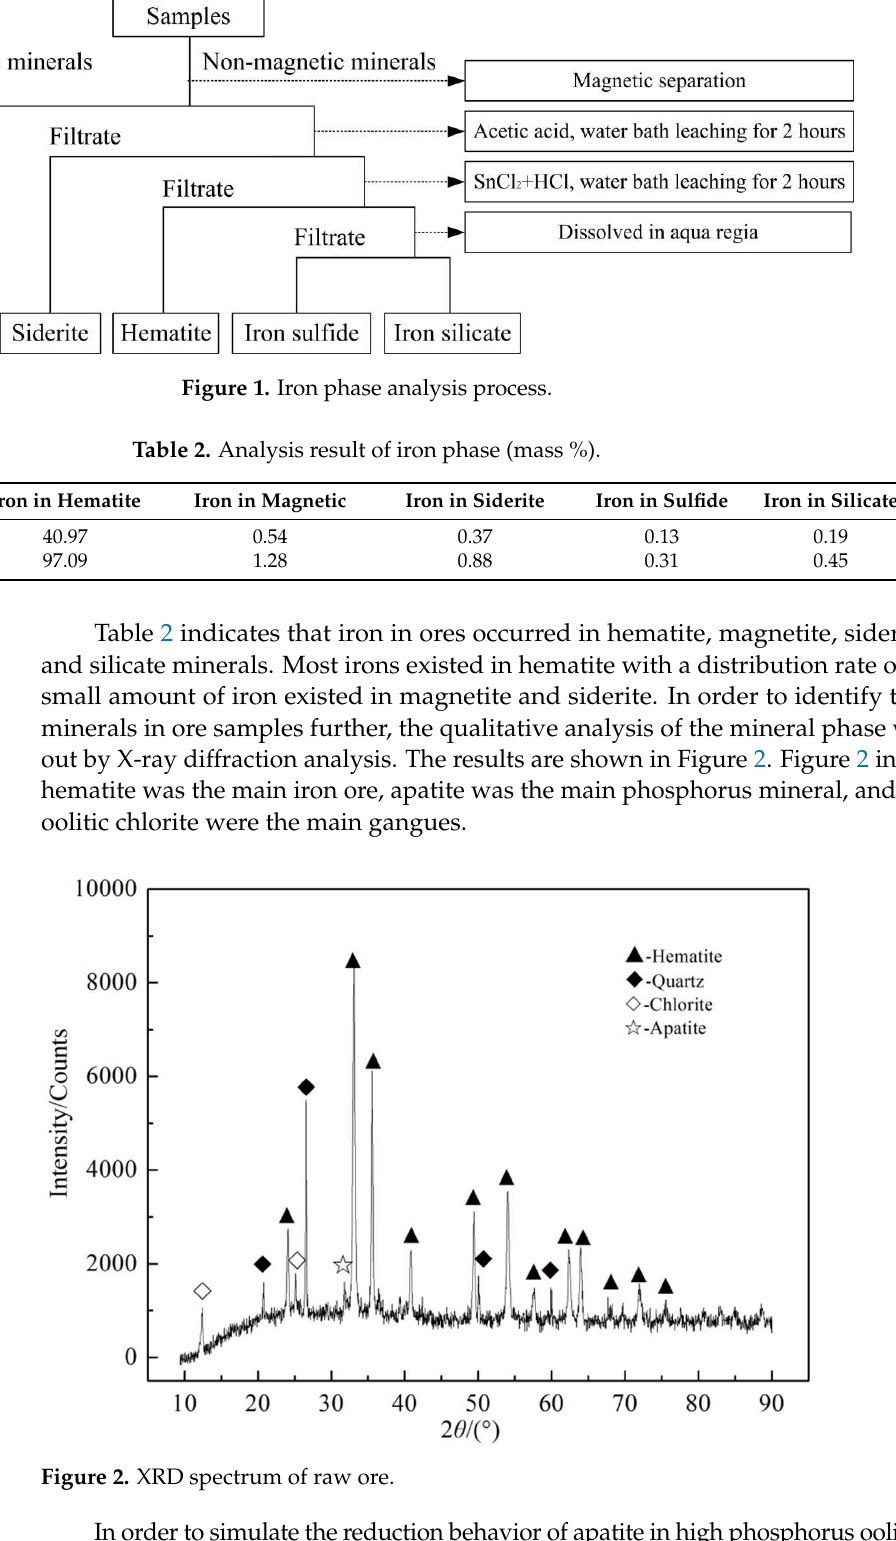
Table 2. Analysis result of iron phase (mass %).